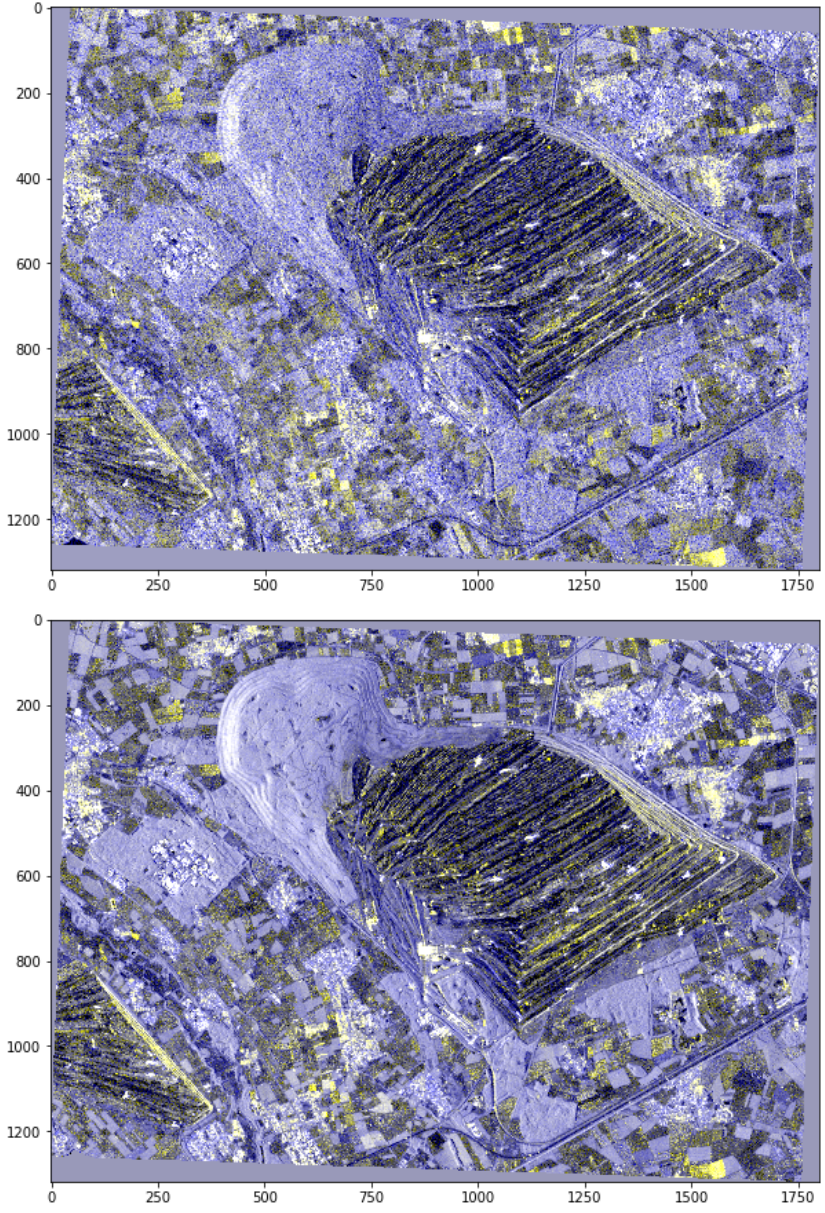
Figure 1. Top: RGB composite ( R = | S vv | 2 , G = | S vv | 2 , B = | S vh | 2 ) of a polarimetric Sentinel-1 SAR image acquired 27 Sept 2018 over the Hambach open-cast mine near Jülich, Germany. The bright features in the mine pit are very large mobile excavators and back fillers. Bottom: The adaptive temporal speckle filter